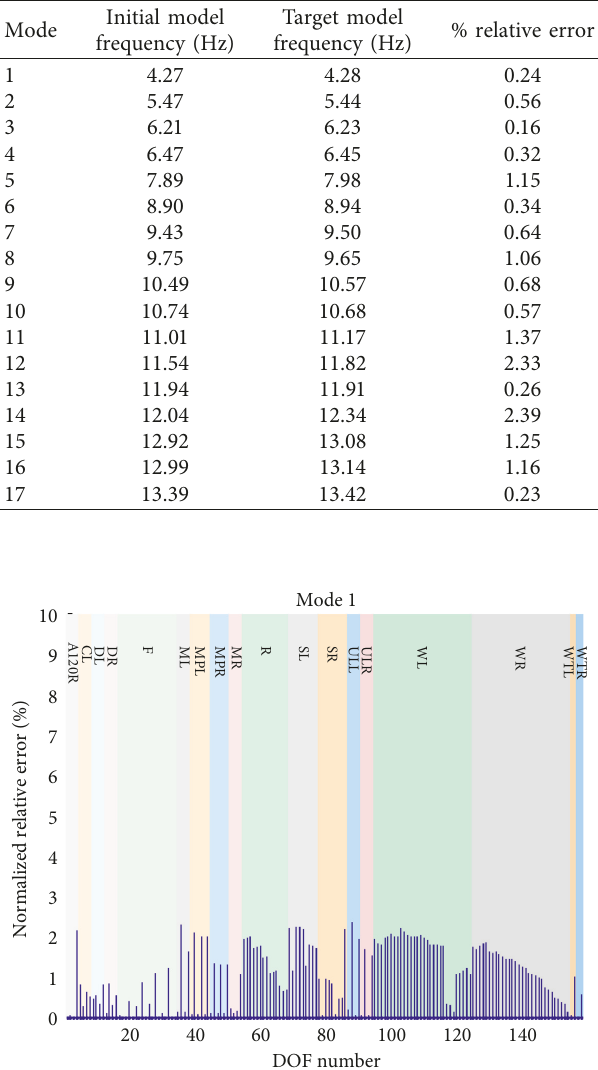
Figure 11: MAC of configuration 1 vs. configuration 3. Table 10: Natural frequencies for configuration 3.